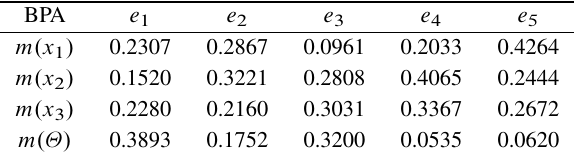
Table 2 BPA of x i with respect to e j :